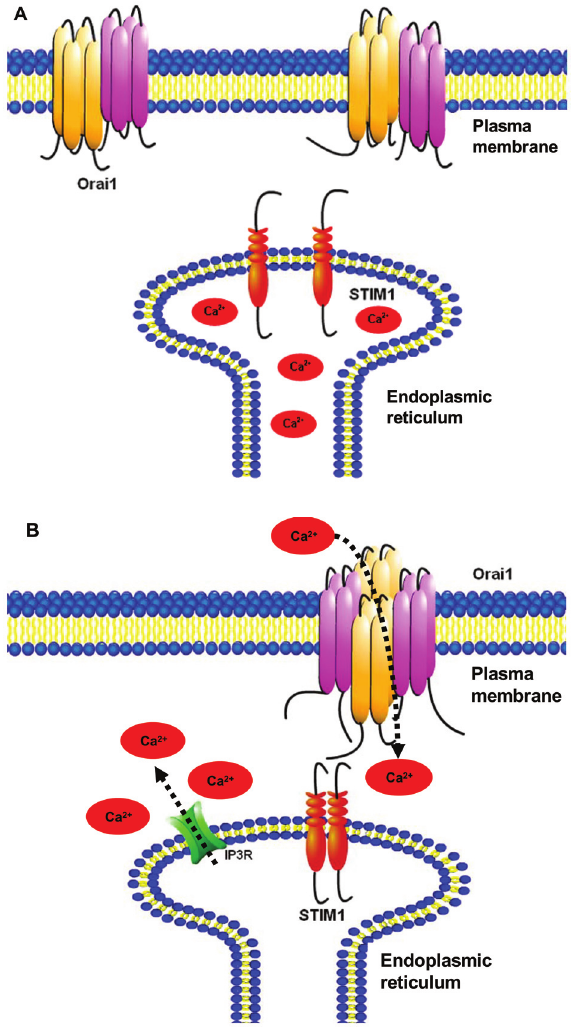
Figure 1. Ca 2+ entry pathways can be mediated by Orai1, by ac- tivation of STIM1. A , Orai1 is a protein with four transmembrane regions in the plasma membrane. Under basal condition, when Ca 2+ is abundant in the endoplasmic reticulum, Orai1 is predomi- nantly a dimer in the plasma membrane. B , STIM1 is a single transmembrane-spanning protein located in the endoplasmic re- ticulum and plasma membrane. Under Ca 2+ store depletion, e.g., when 1,4,5- inositol trisphosphate (IP 3 ) is formed and binds to its receptor (IP 3 R) on the endoplasmic membrane, and Ca 2+ is re- leased from stores, the reduced luminal Ca 2+ causes dissociation of Ca 2+ bound to the low-affinity helix-loop-helix Ca 2+ -binding site domain on the N-terminus of STIM1. This Ca 2+ dissociation causes STIM1 molecules to aggregate and be translocated to re- gions of the endoplasmic reticulum in close proximity to the plas- ma membrane. Interaction with the C-terminus of STIM induces Orai dimers to dimerize, forming tetramers that constitute the selective Ca 2+ pore of the channel, which is a highly Ca 2+ selec- tive store-operated channel moiety. Association of STIM1/Orai1 initiates Ca 2+ influx and consequently I CRAC . STIM1 = stromal interaction molecule 1; I CRAC = Ca 2+ release-activated Ca 2+